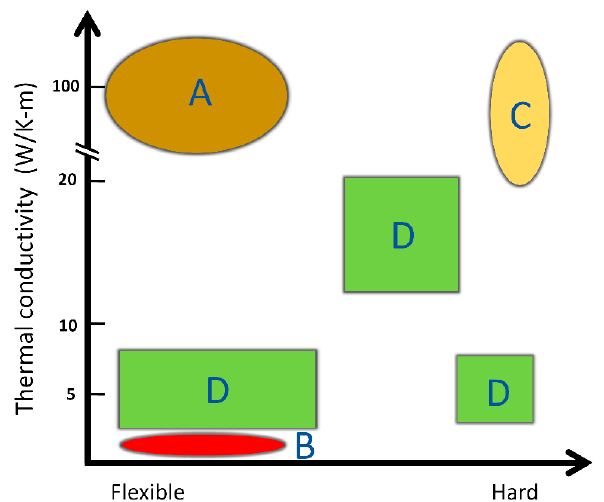
Figure 1. A and B are the ideal areas of thermal conductive and thermal insulating materials using protein-based polymers, respectively; C areas represent metal-based or ceramic-based materials that have both high thermal conductivity and high elastic modulus; D areas represents the typical synthetic polymer-based heat transfer materials that currently exist in the market.